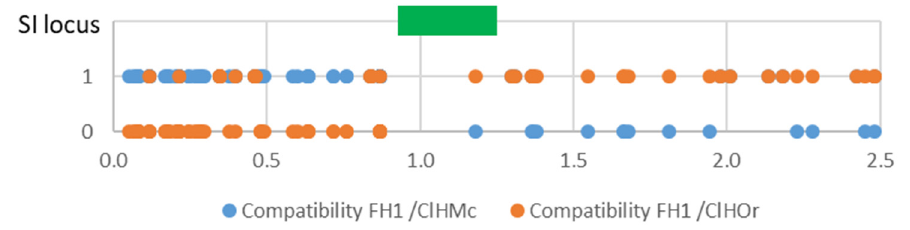
Figure 6. Compatibility of the FH1 haplotype of ‘Fortune’ mandarin with the mandarin haplotype (ClHMc) and sweet orange haplotype (ClHOr) of clementine for SNP markers near the SI locus (green rectangle); x axis: position in the chromosome 7 in Mb.